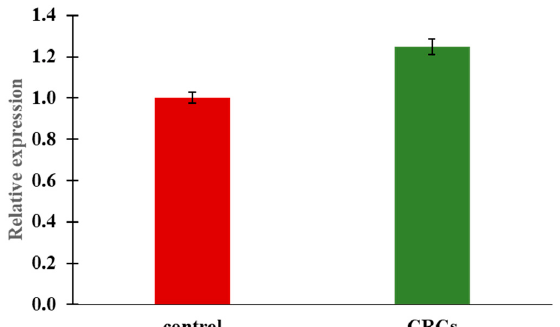
Figure 3. Expression of insa following 48h treatment with CRCs at the concentration of 0.2 mg/mL. Insa is significantly upregulated compared to the control treated embryos whose gene expression was set as 1. mRNA expression was normalized against ef1a . Data are mean +/ − standard error of the mean (SEM), n = 3, p < 0.01.